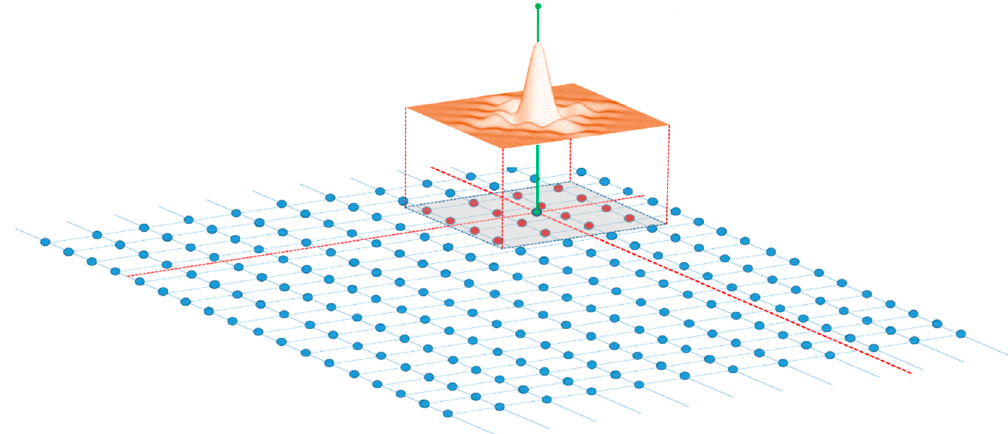
Figure 3. Pictorial description of the convolution-based 2D interpolation scheme based on a finite-support kernel in the spatial domain.